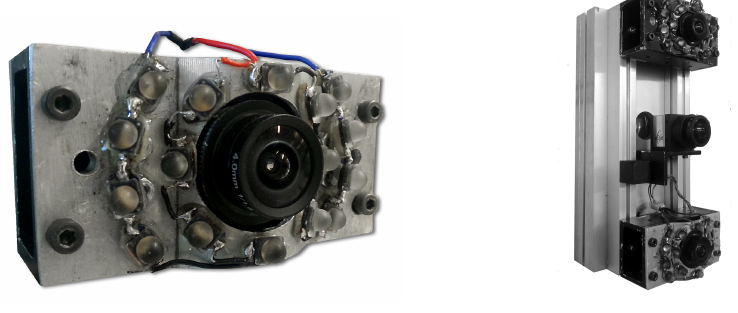
Figure 4. Examples of unwrapped input images as captured by ( a ) a color camera; ( b ) the NIR camera using flash; and ( c ) the NIR camera without using flash. The top row shows images taken in an indoor environment and in the absence of any secondary NIR light source, resulting in a completely dark image background. The bottom row illustrates images captured outdoors under strong backlight conditions, leading to much higher background